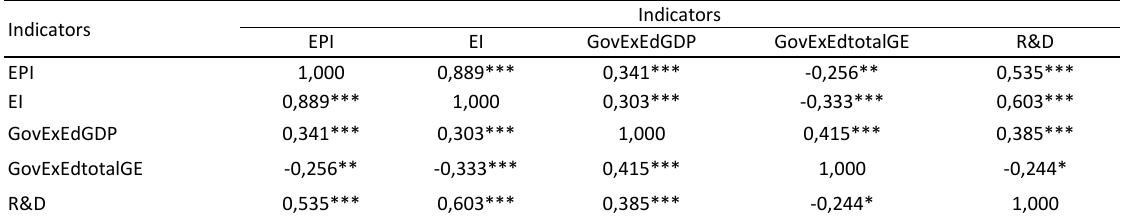
Table 1: Correlation matrix of the EPI and indicators characterizing educational and science level in the Table 1: Correlaon matrix of the EPI and indicators characterizing educaonal and science level in the country Indicators